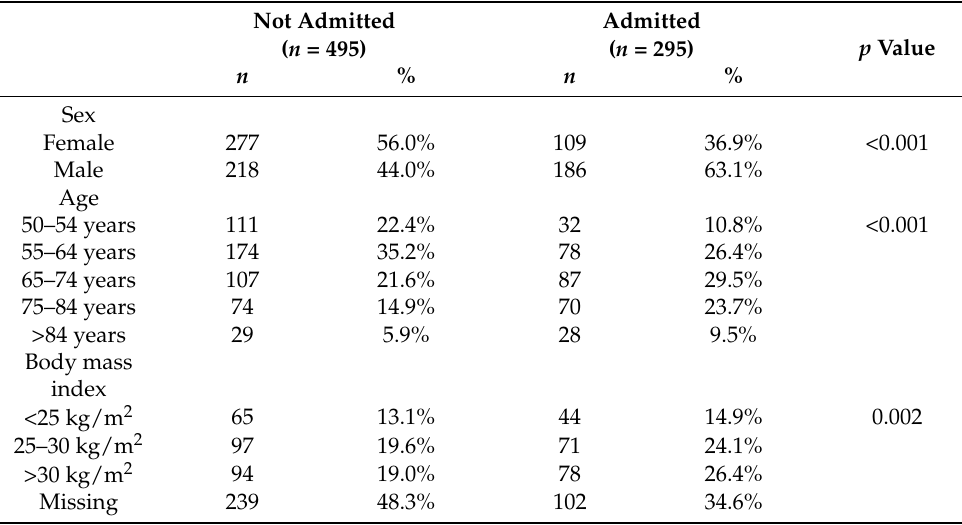
Figure 1. Most frequent comorbidities. Table 1. Variables associated with hospital admission for COVID-19, bivariable analysis.